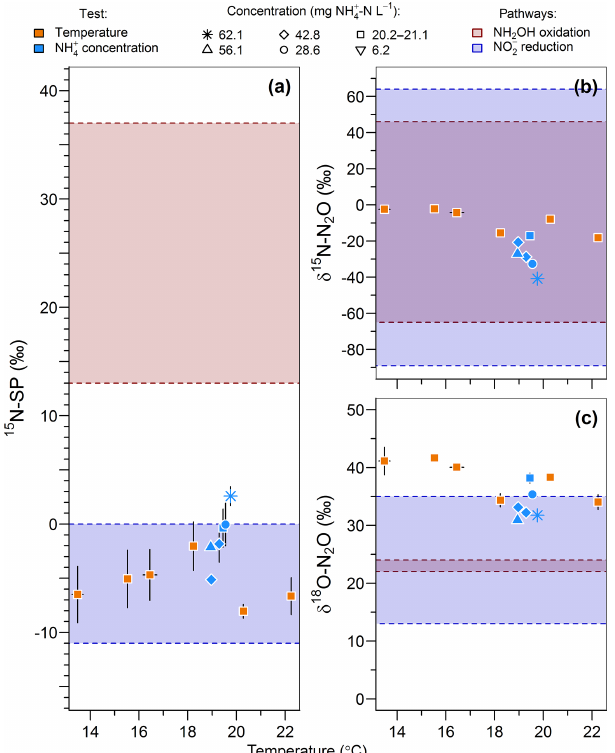
Figure 6. Effect of temperature (orange symbols) and inflow ammonium concentration (blue symbols) on (a) the nitrogen isotopomer site preference, (b) the nitrogen isotope ratio and (c) the oxygen isotope ratio of N 2 O. Average and standard deviation (error bars) are calculated for the samples taken after one hydraulic retention time. Note that the isotopic measurements of gas samples taken at inflow ammonium concentration of 42.7 and 42.9mgNL − 1 were both recorded as 42.8mgNL − 1 in the